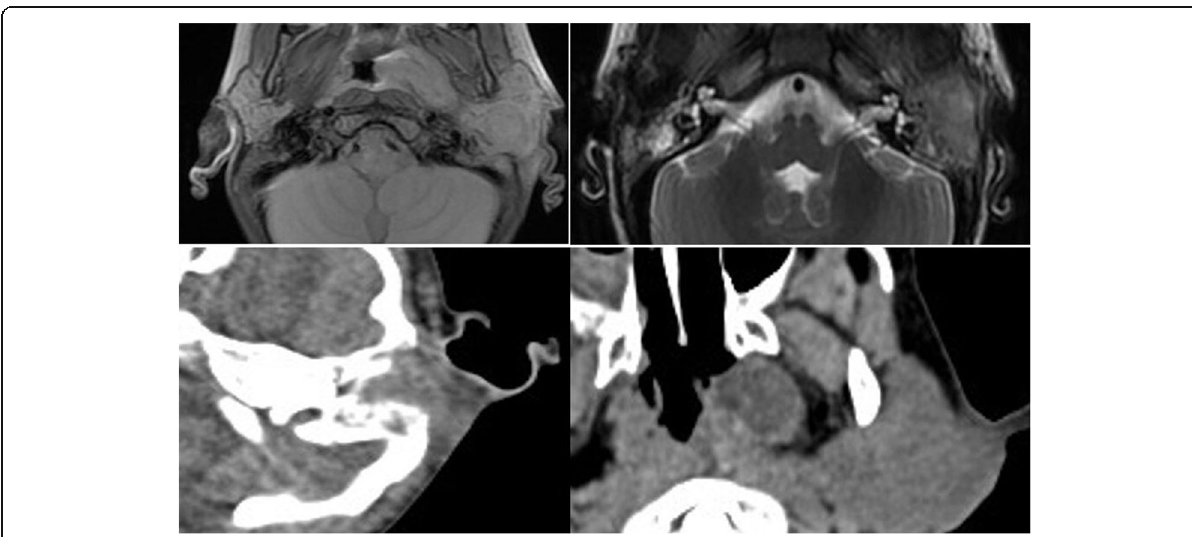
Fig. 2 Pre-operative imaging of the patient. Upper left: Axial MRI T1 with no contrast showing the mass of the left side occupying both the parotid region and the parapharyngeal space. Upper right: Axial MRI T2 at the level of internal auditory canal showing the mass in the left mastoid and middle ear region. Lower left: axial CT bone window of the left petrous bone showing total opacification by the mass of the external and middle ears and mastoid cavity and its erosion. Lower right: Axial CT bone window at the level of the nasopharynx showing left parapharyngeal and parotid region affection by the mass